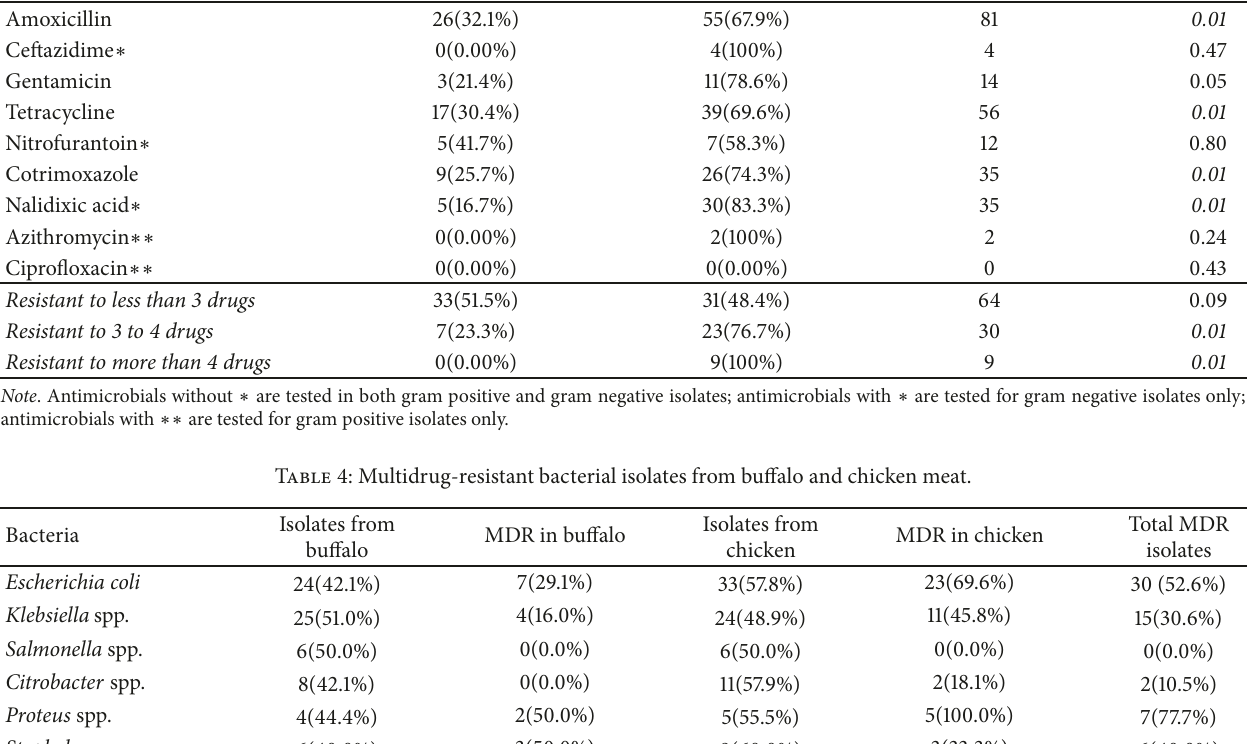
Table 3: Prevalence of antimicrobial resistance in isolates from raw buffalo and chicken meat samples. Antimicrobials